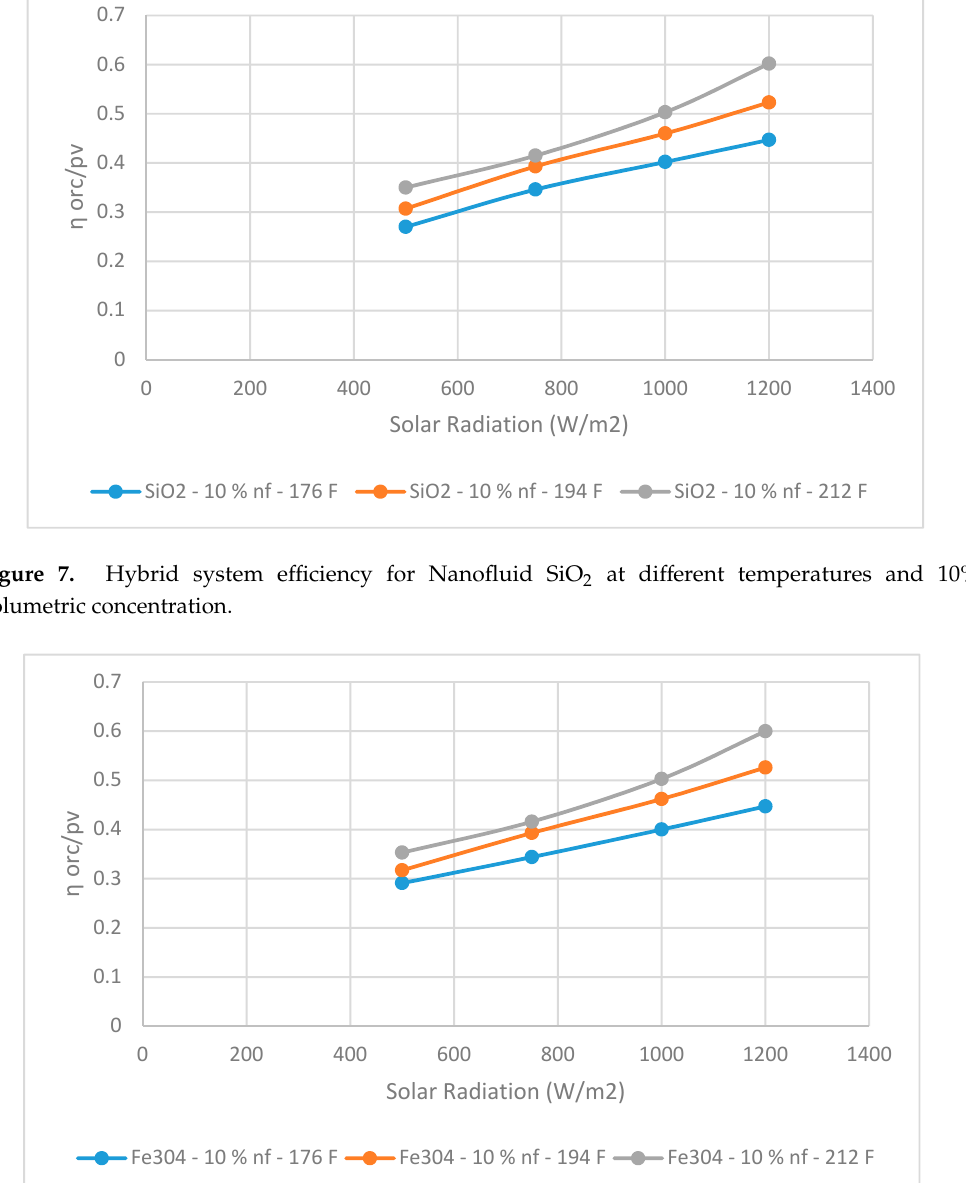
Figure 8. Hybrid system efficiency for Nanofluid Fe 3 O 4 different temperatures and 10% volumetric concentration.